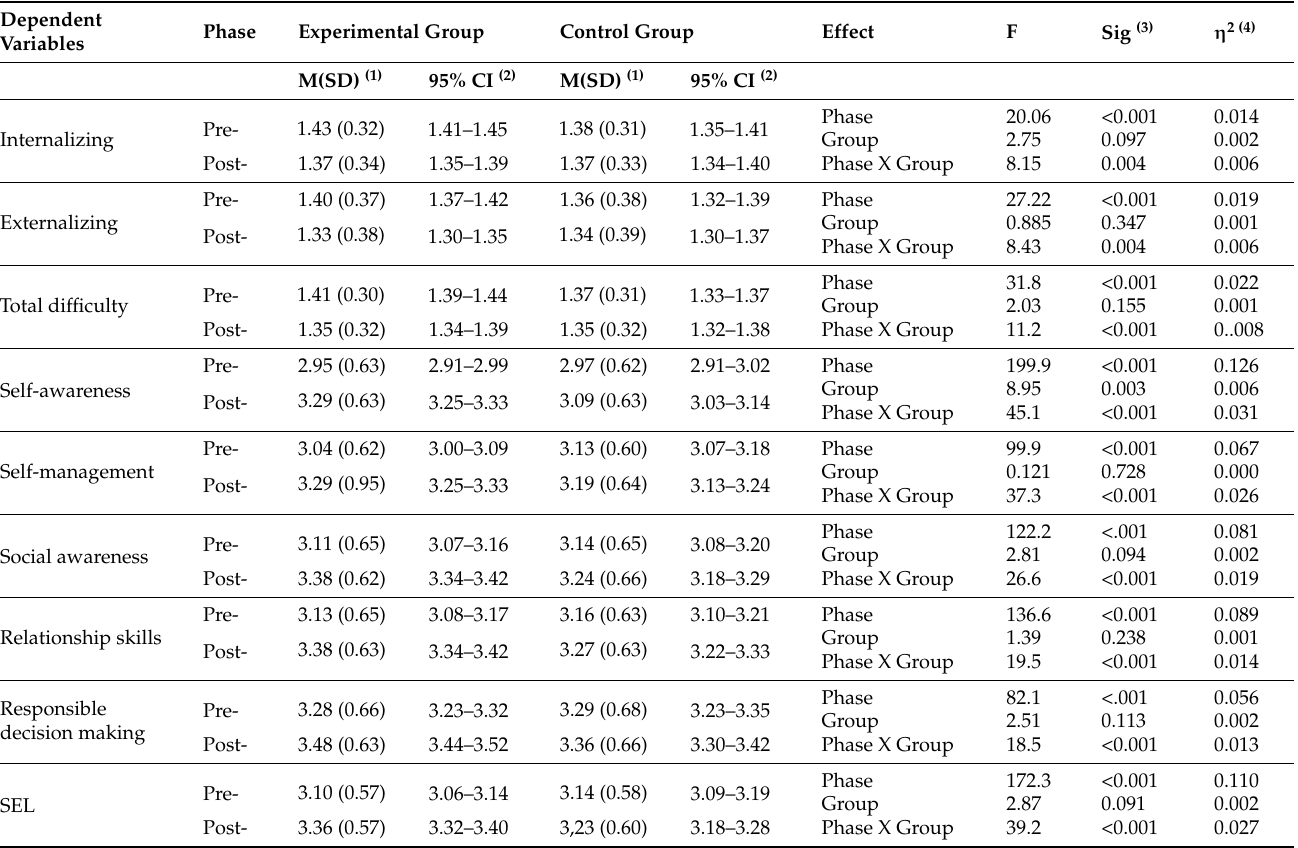
Table 4. Mean, standard deviation, confidence interval, and significance of the main effects and interaction effects between phase and